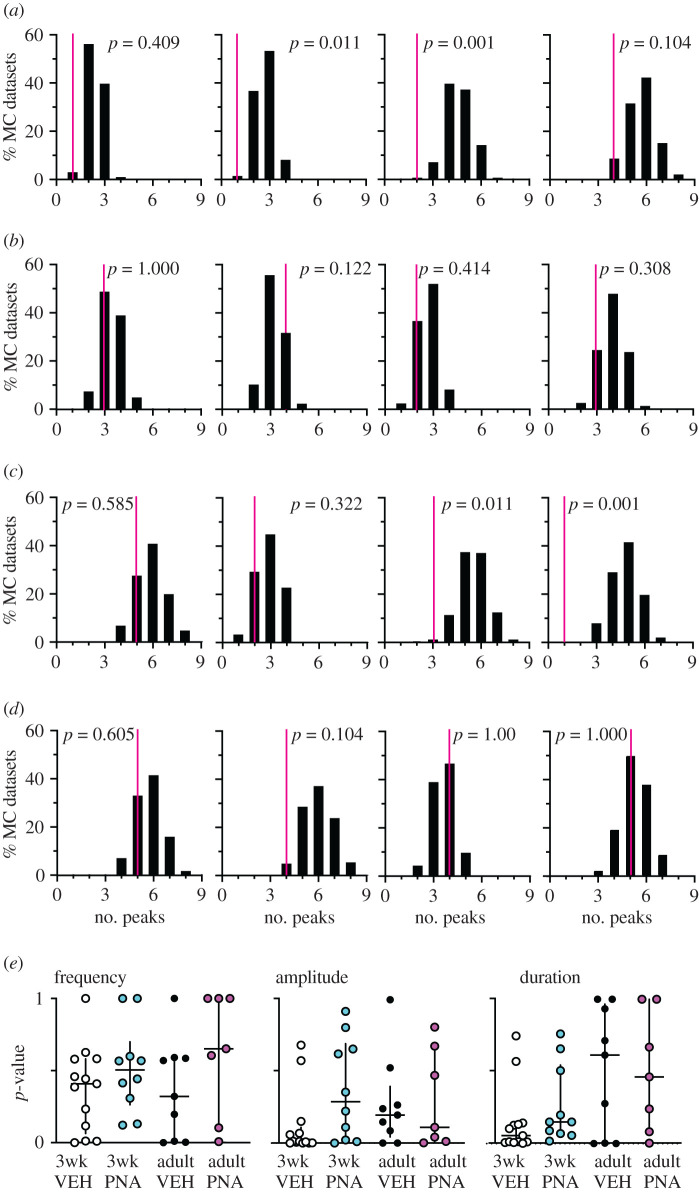
Original data (magenta line) versus MC distribution for four representative recordings from each group. (a–d) Representative examples of the distribution of number of peaks detected by Cluster in the 1000 MC datasets. p-values indicated are from cell versus itself analysis comparing original data to its MC dataset distribution. (a) three-week-old vehicle; (b) three-week-old PNA; (c) adult vehicle; (d) adult PNA. (e) p-values for each cell from cell versus itself analysis comparing original data to its MC distribution for frequency of peaks (left), peak amplitude (centre) and peak duration (right).